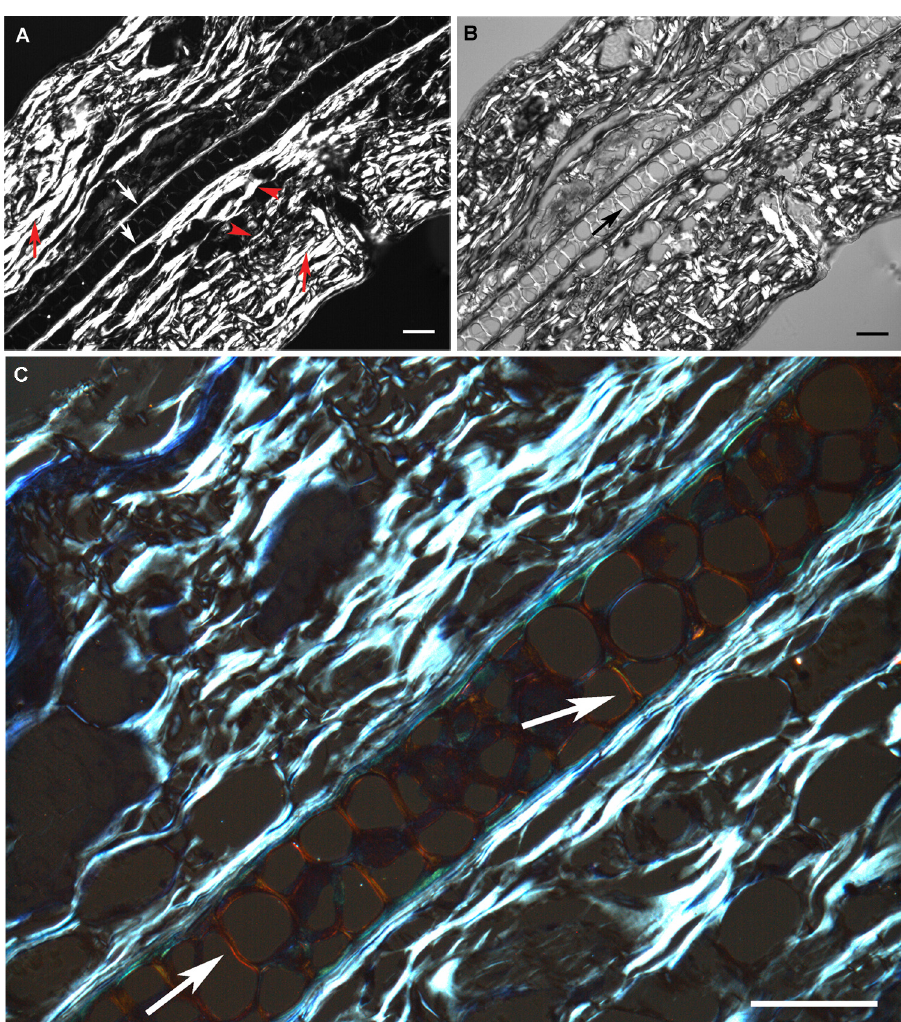
Fig 2. Images of cartilage ECM and CB birefringence in unstained (A, B) and toluidine blue-stained ear sections (C). In A, birefringence intensity is dependent on the orientation and degree of aggregation of CBs (red arrows); white arrows indicate the perichondrium (collagen type I), and arrowheads indicate perichondrium coalescent collagen fibers. In B, the same image as in A, a partial compensation of birefringence is shown in CBs and perichondrium oriented from the SW to the NE direction. Completely compensated birefringence is demonstrated by black color. The most densely aggregated fibers do not exhibit total birefringence compensation. Birefringence of cartilage ECM regions (black arrow) and CBs distributed with their long axis oriented from the SE to the NW direction was not compensated. In C, abnormal interference colors of birefringence are observed in the cartilage. The white arrow indicates cartilage regions with enhanced birefringence intensity due to a Cotton effect-like phenomenon [15, 23]. In this case, no birefringence compensation was performed. Bars = 50 μ